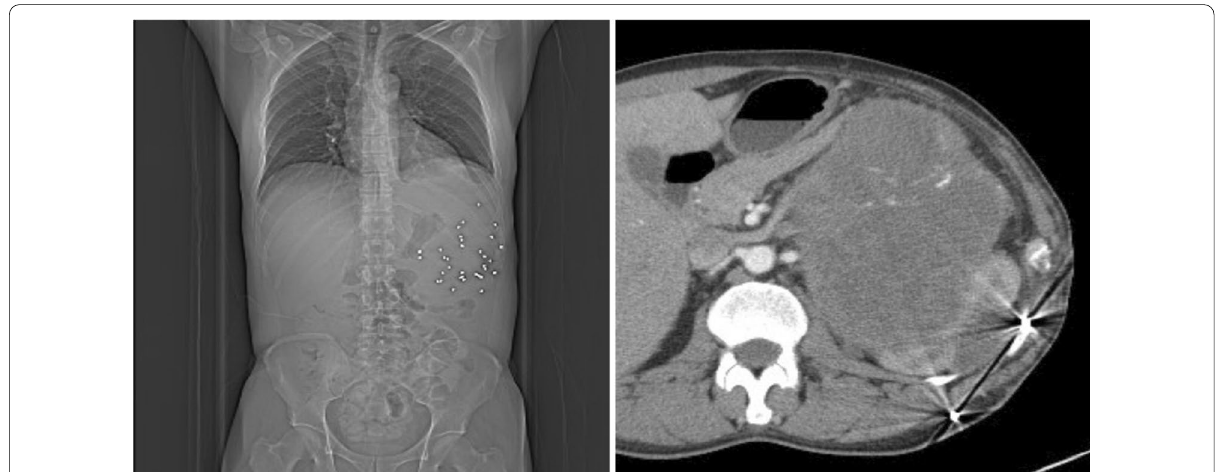
Fig. 1 Left: X-ray with remnant gun pellets. Right: CT scan with tumor and left kidney